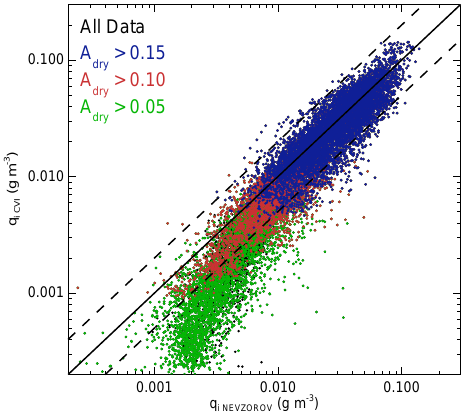
Figure C1. A comparison of 1Hz Nevzorov data and CVI q i measurements taking the minimum detectable absorptance of the Lyman- α hygrometer into account. The solid line is the 1 : 1 line and the dashed lines represent a factor-of-2 difference between the measurements. See text for